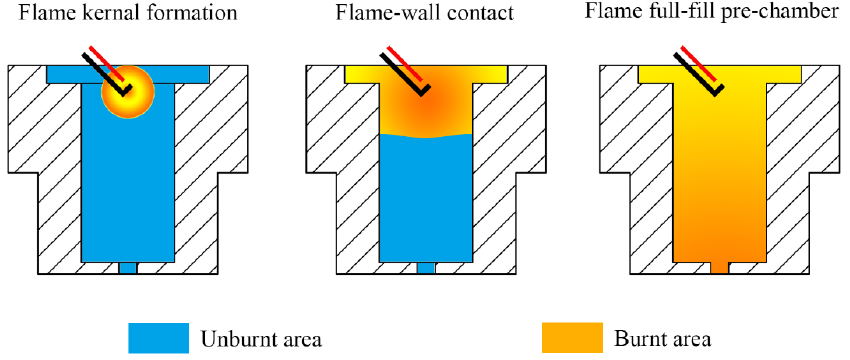
Figure 8. Flame generation and propagation inside the pre-chamber.